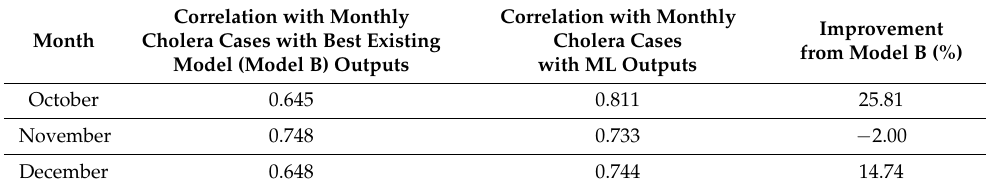
Table 6. Improvement (%) offered by the machine learning model from the best geospatial models. Correlation with Monthly Month Cholera Cases with Best